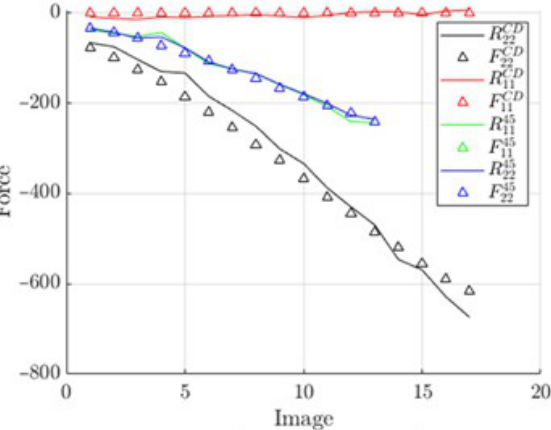
Figure 15. Curves reconstructed from the identified A matrix vs. measured force.